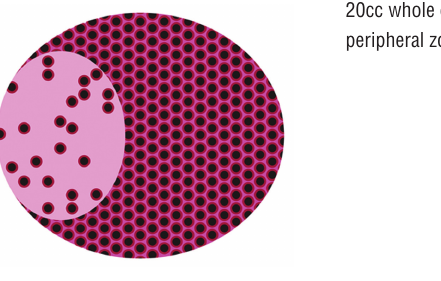
Figure 1 - Normal gland 20cc schematic diagram. 70% PZ by volume 30% TZ by volume. PZ 80% acini 20% stroma (cells red, lumen black, stroma